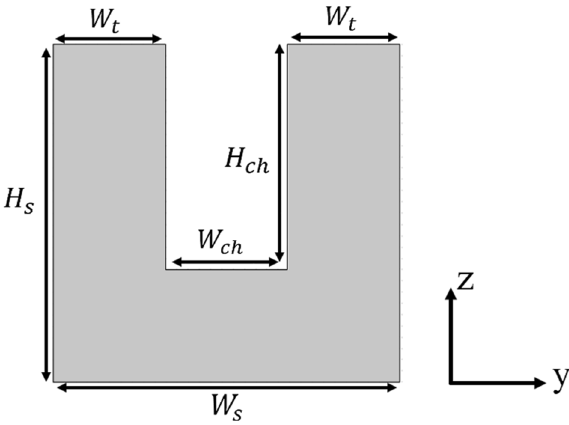
Figure 1. The cross-section of studied microchannels.